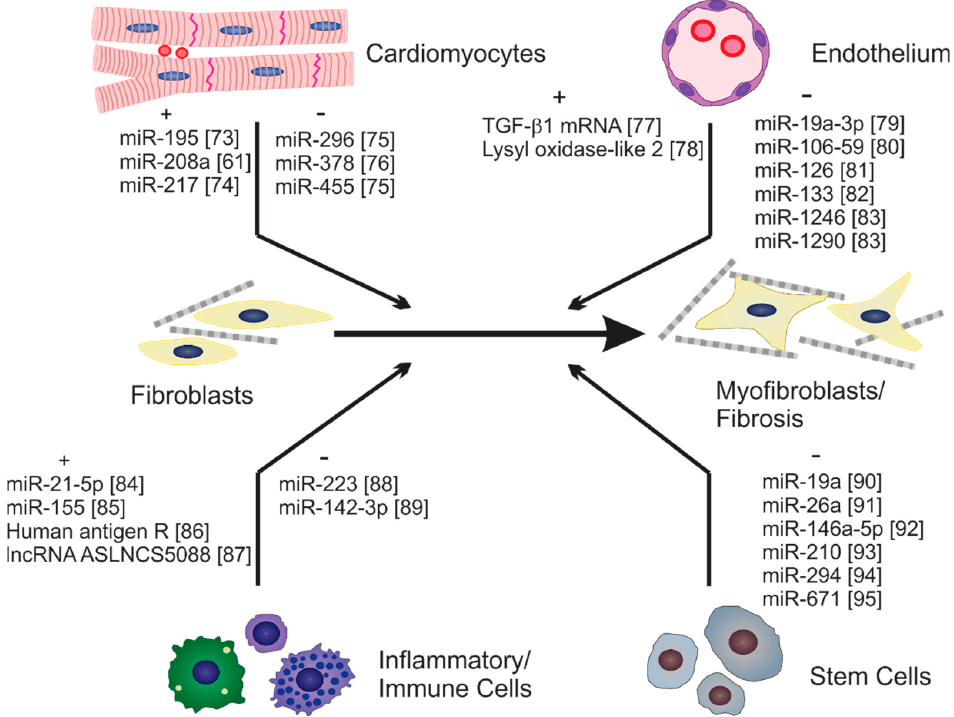
Figure 1. Cells that secrete exosomes modulating fibrosis. A schematic illustration of examples of identified cells and cargo that modulate fibroblast activation and/or fibrosis. Only components that have been functionally validated to alter fibroblast activation or fibrosis and whose cell-of-origin have been identified are included. Note that exosomes and their cargo can have both positive (+) and negative ( − ) effects on fibrosis [73–95].